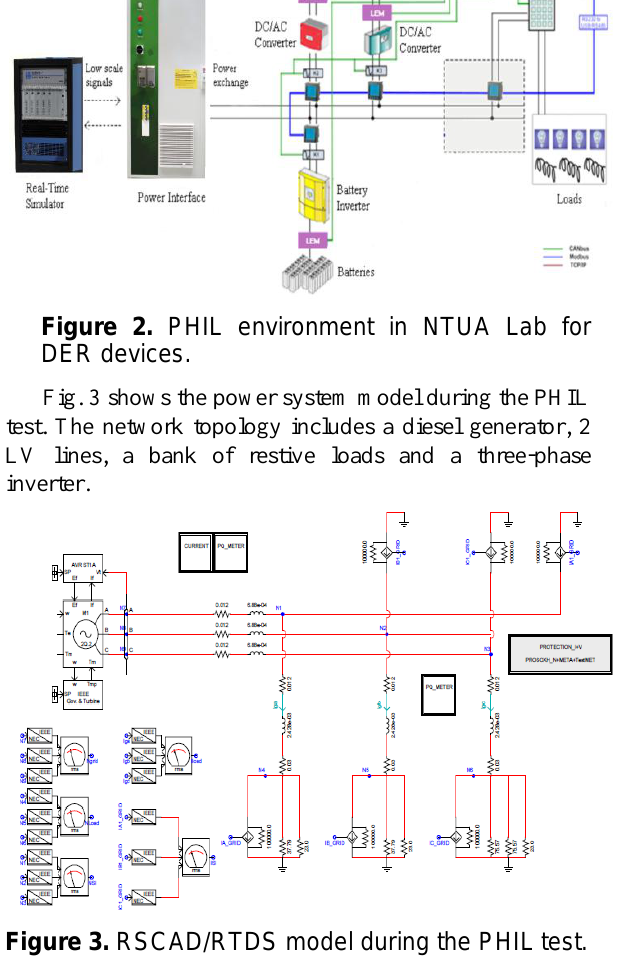
Table 1. System parameters